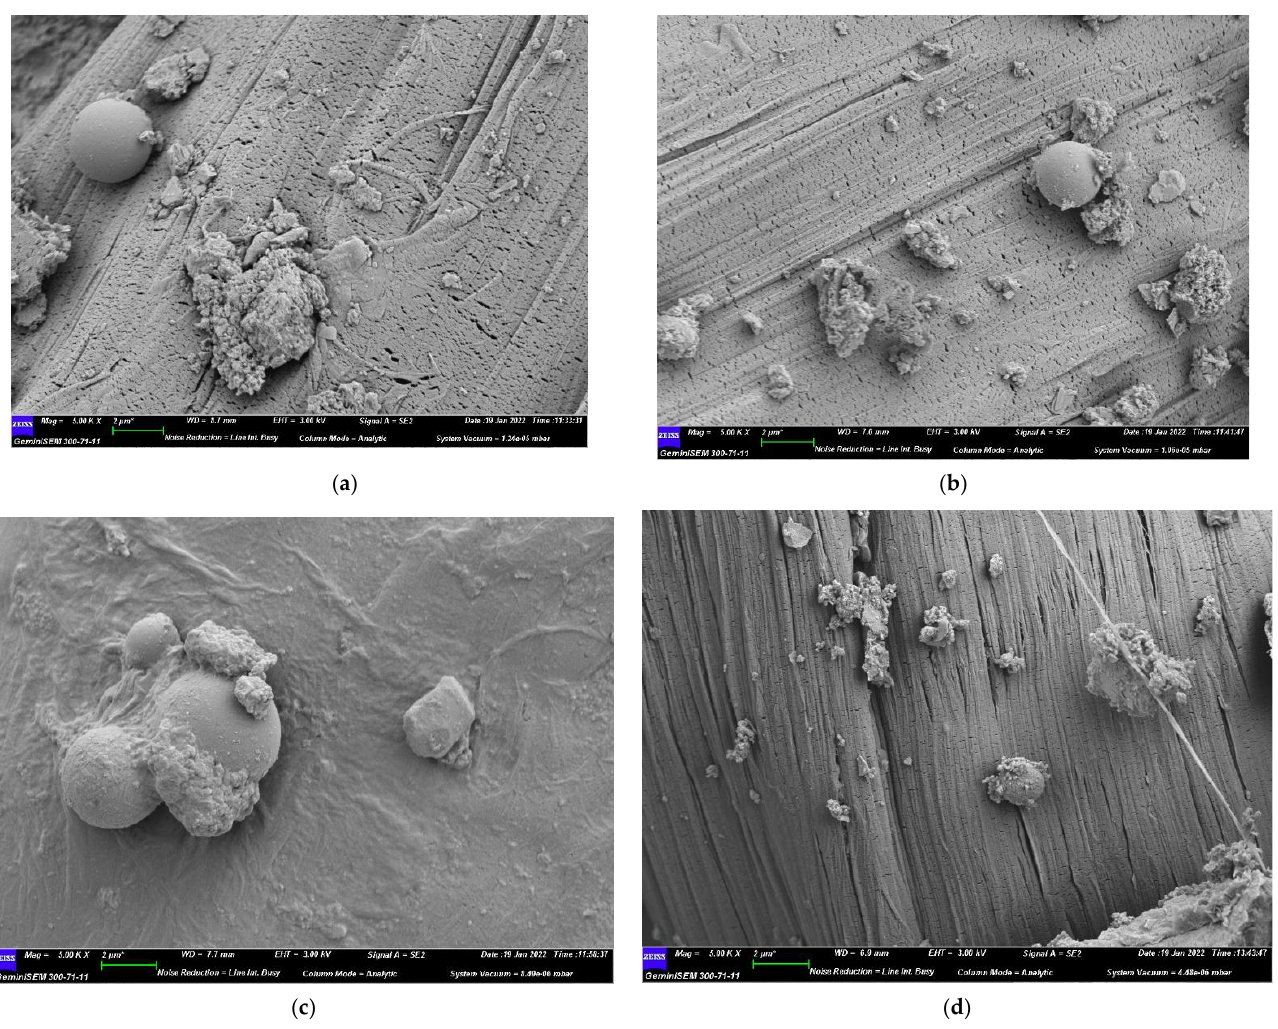
Figure 11. SEM results on day 7. ( a ) SF-0-60, ( b ) SF-5-55, ( c ) SF-10-50, ( d ) SF-15-45.